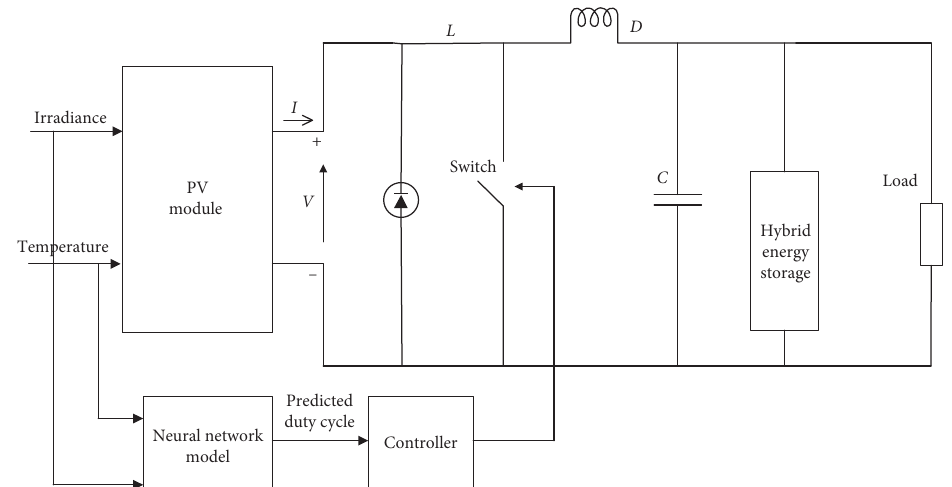
Figure 34: Solar Energy Harvesting System with MPPT-based neural network algorithm.